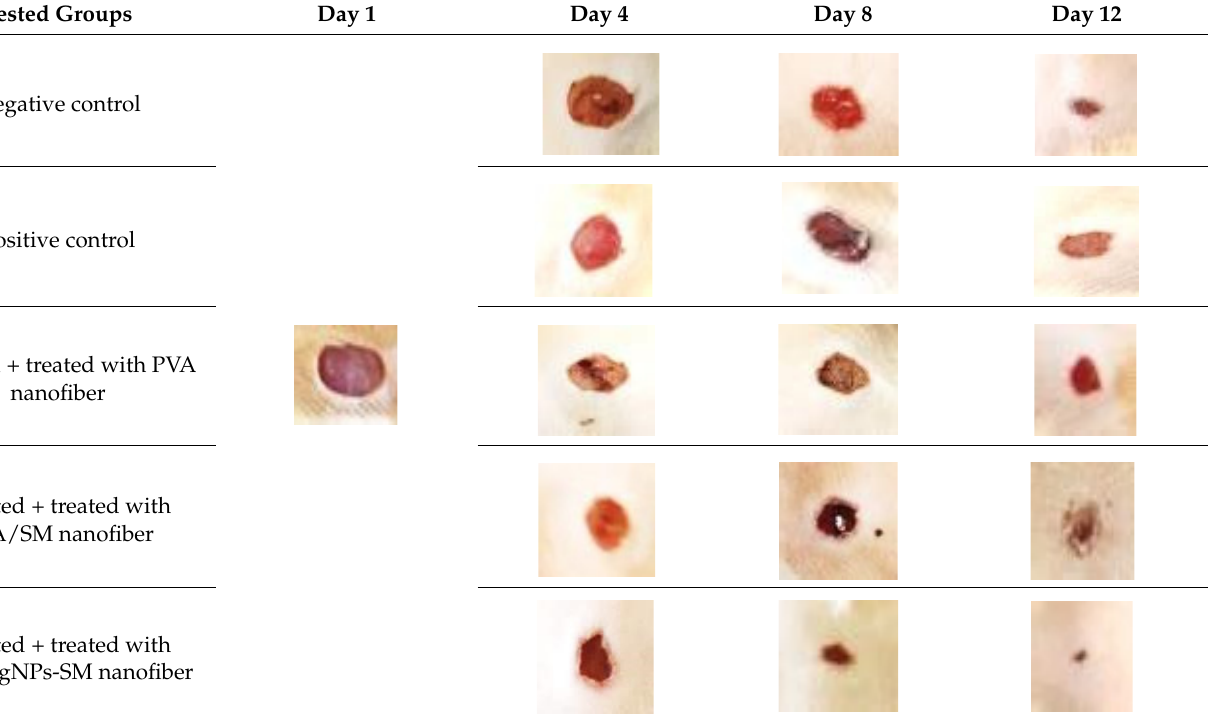
Figure 8. Wound healing area as affected by time intervals.